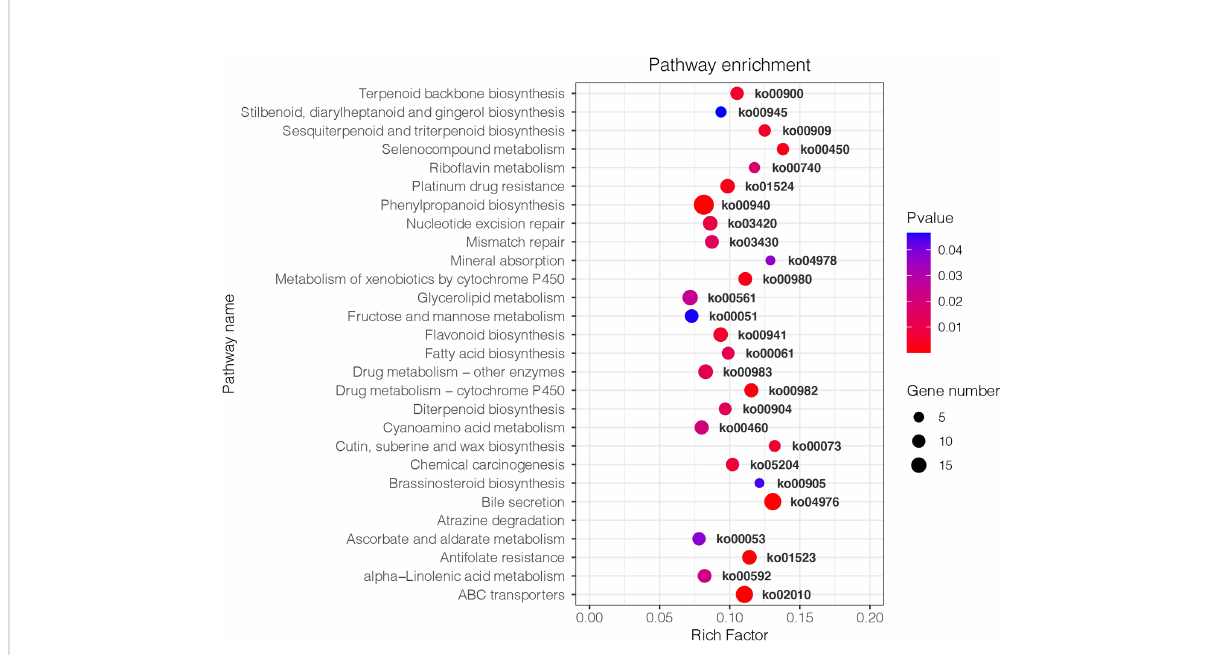
FIGURE 4 Kyoto Encyclopedia of Genes and Genomes (KEGG) enrichment analysis of DEGs in Pyrus betulaefolia roots between Fm and S. The size of the points represents the number of differentially expressed genes, and different colors represent different P -values. The larger the Rich Factor is the higher the degree of enrichment. S, soil from S in Trifolium repens mixed with sterilized standard soil; Fm, Funneliformis mosseae inoculum mixed with sterilized standard